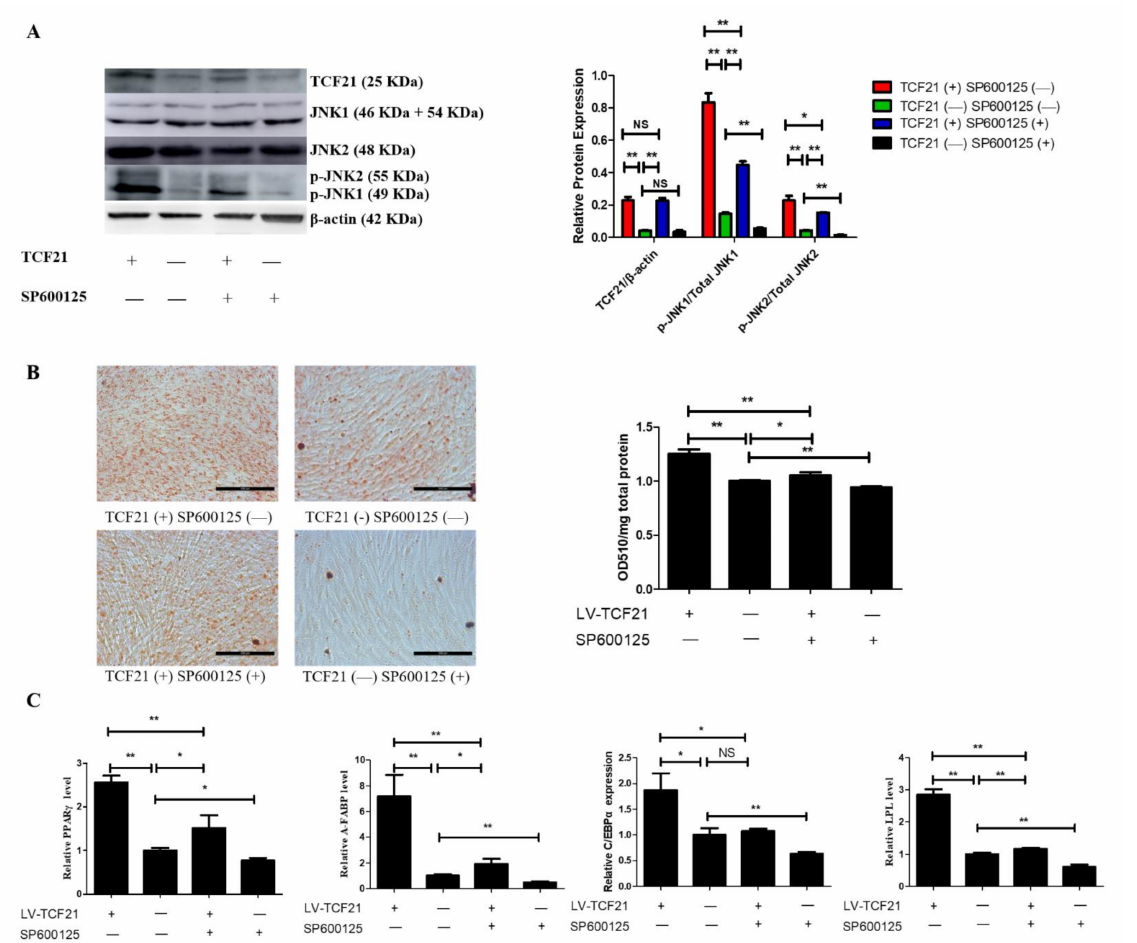
Figure 3. Inhibition of MAPK/JNK signaling attenuates TCF21-mediated enhancement of preadipocyte differentiation. At 24 h post-induction of differentiation, LV-TCF21 and LV-control preadipocytes were then incubated for an additional 24 h in differentiation medium containing either 0 or 10 µ M SP600125. ( A ) Images for JNK1, JNK2, p-JNK1, p-JNK2, and β -actin expressions in LV-control or LV-TCF21 cells treated with 0 or 10 µ M SP600126 by Western blotting (representative of three independent experiments). Then, the bands intensities were quantified by Image J software. Graphs are plotted as mean ± SE from three independent experiments. NS, no significance, * p < 0.05, ** p < 0.01; ( B ) images for oil-red O staining of lipid droplets in differentiated LV-control or LV-TCF21 preadipocytes treated with 0 or 10 µ M SP600125 (representative of three independent experiments). Then, oil-red O dye was extracted from the cells in order to quantify staining intensity. Graphs are plotted as mean ± SE from three independent experiments relative to staining intensity of LV-control treated with 0 µ M SP600125. * p < 0.05, ** p < 0.01; ( C ) expressions of pro-adipogenic genes in differentiated LV-control or LV-TCF21 preadipocytes treated with 0 or 10 µ M SP600125 by real-time PCR. Graphs are plotted as mean ± SE from three independent experiments relative to the gene expression in LV-control treated with 0 µ M SP600125. NS, no significance, * p < 0.05, ** p <